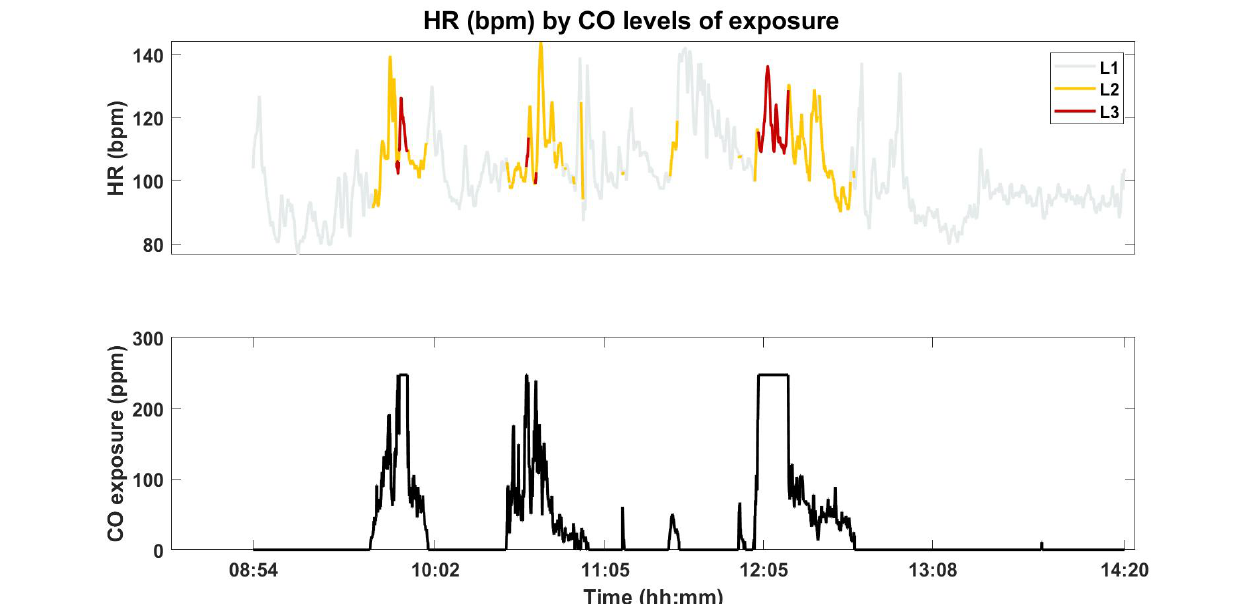
Figure 3. The FF7’s HR according to the CO levels of exposure ( top ) and the measured CO concentration ( bottom